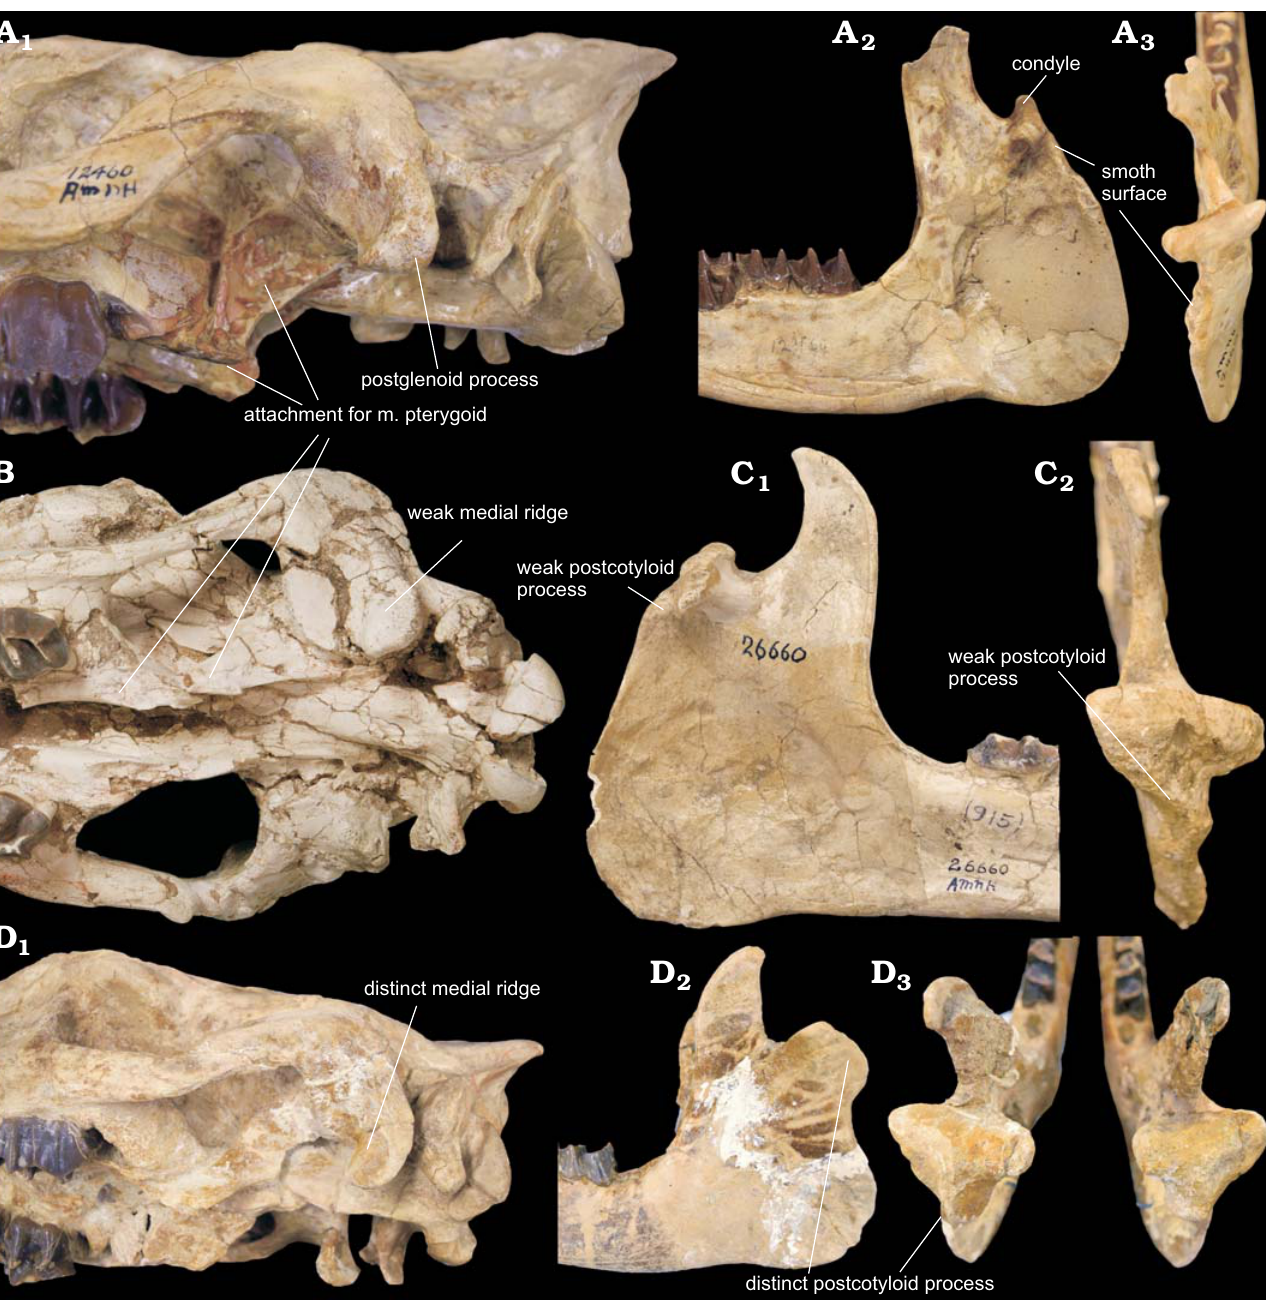
Fig. 5. Morphology of craniomandibular articulation in hyracodontids, Pappaceras , and rhinocerotids. A . Hyracodontid Hyracodon nebraskensis Leidy, 1850 (AMNH 12460) from Oligocene of Nebraska, USA. Cranium in lateroventral view (A 1 ); right mandible in medial (A 2 ) and dorsoposterior (A 3 ) views. B . Paraceratheriid Pappaceras meiomenus H.B. Wang, Bai, Meng, and Y.Q. Wang, 2016 (IVPP V20254) from the late Early Eocene Arshanto Formation, Erlian Basin, Nei Mongol, China; cranium in ventral view. C . Para ceratheriid Pappaceras confluens Wood, 1963 (AMNH 26660) from the late Early Eocene Arshanto Formation, Erlian Basin, Nei Mongol, China; left mandible in medial (C 1 ) and dorsoposterior (C 2 ) views. D . Rhinocerotid Subhyracodon occidentalis Leidy, 1850 (AMNH 534) from Oligocene of South Dakota, USA; cranium in lateroventral view (D 1 ), mandibles in lateral (D 2 ) and dorsoposterior (D 3 )